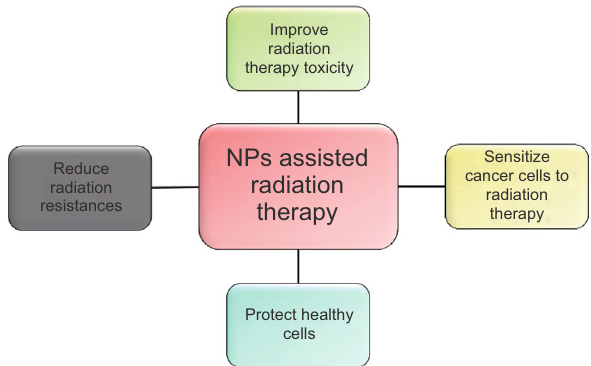
Fig. 2 Schematic view on how the NPs can improve the efficacy of the radiation therapy in cancer